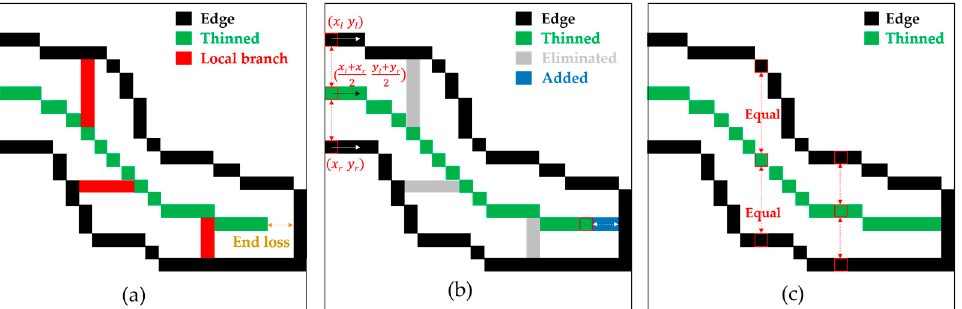
Figure 6. Schematic diagram of crack skeleton extraction: ( a ) traditional approach has local branches and crack end loss in thinning; ( b ) schematic diagram of the proposed method; ( c ) thinning results of the proposed method.